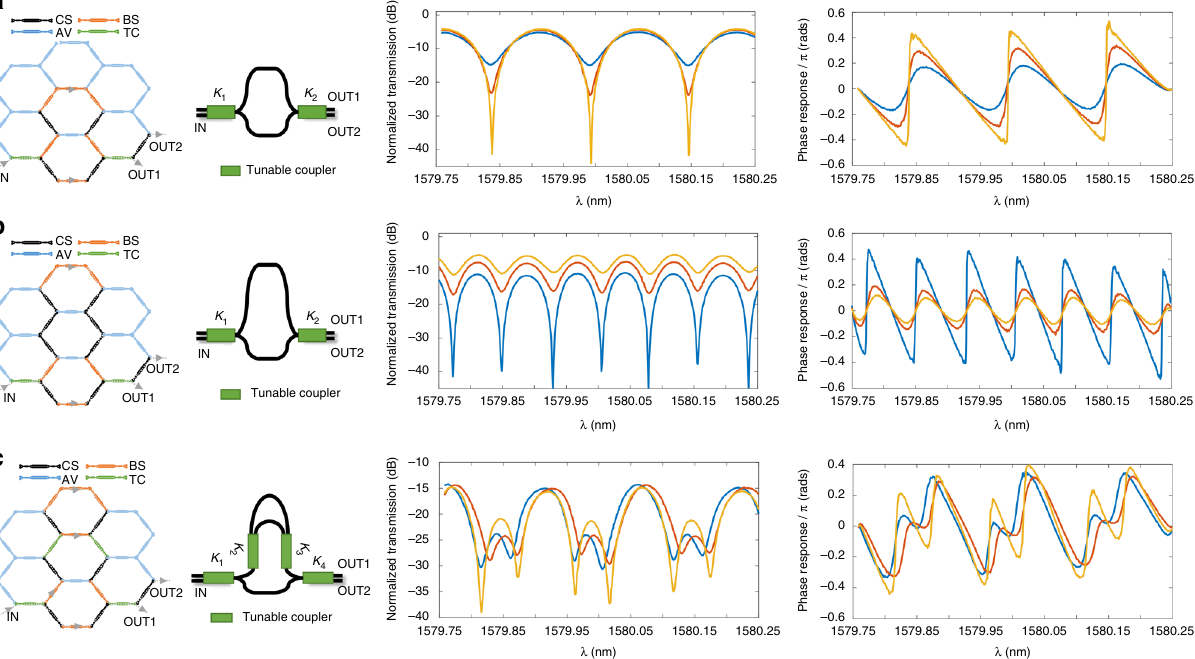
Fig. 3 Experimental results for tuneable unbalanced Mach Zehnder Interferometers and fi nite impulse response fi lters. Waveguide mesh connection diagram, circuit layout and measured modulus, and phase transfer function for different values of the coupling constants K 1 and K 2 in the case of a a 4-BUL unbalanced Mach-Zehnder Interferometer ( UMZI ) fi lter; b an 8-BUL UMZI fi lter; c a 4-BUL basic delay 3-tap transversal fi lter. For each case, the fi rst column shows the 7-cell hexagonal waveguide mesh con fi guration, where each Mach Zehnder Interferometer ( MZI ) device is represented by a given color depending on whether it is activated as a cross ( black ) or bar ( orange ) switch, a tuneable coupler ( green ) or not used/available ( blue ). The second column shows the layout of the implemented structure, while the third and fourth columns show, respectively, the measured modulus and corresponding phase (calibrated by the shortest path) for the synthesized con fi guration where the input is in the IN port and the output is the OUT1 port. Measured curves are displayed for different values of the coupling constants K 1 and K 2 , which are tuned by changing the injection currents to the heater elements of the input and output MZI devices of the UMZI. Changing these values alters the position of the zero in the UMZI transfer function bringing it closer or farther to the unit circle 42 . The closer the zero is to the unit circle, the deeper are the notches in the transfer function are and the higher is the phase shift step in the transfer function is ref. 42 . BUL, basic unit length; CS, cross state; BS, bar state; AV, available; TC, tuneable